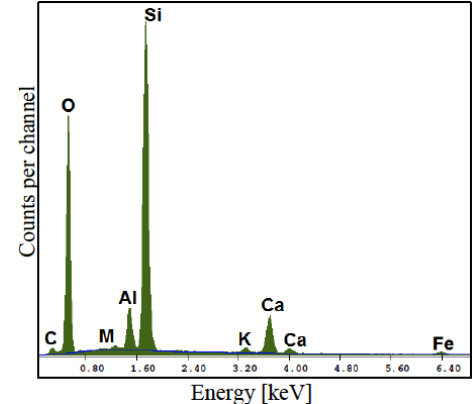
Figure 15: EDS analysis. 2.